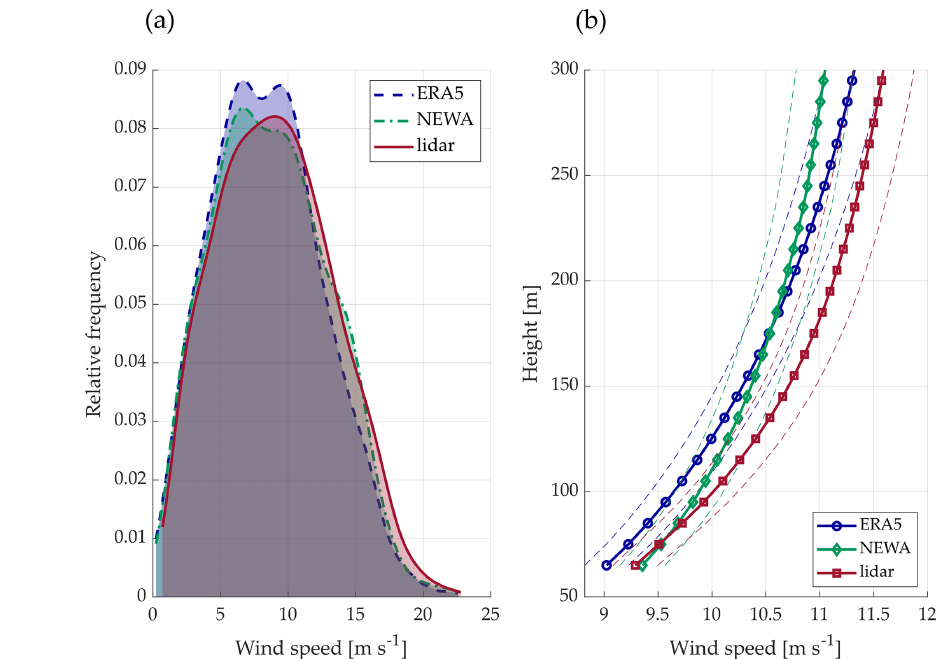
Figure 6. (a) Wind speed kernel distribution at 100m height. (b) Average wind speed profiles. The dashed lines represent the 95% confidence